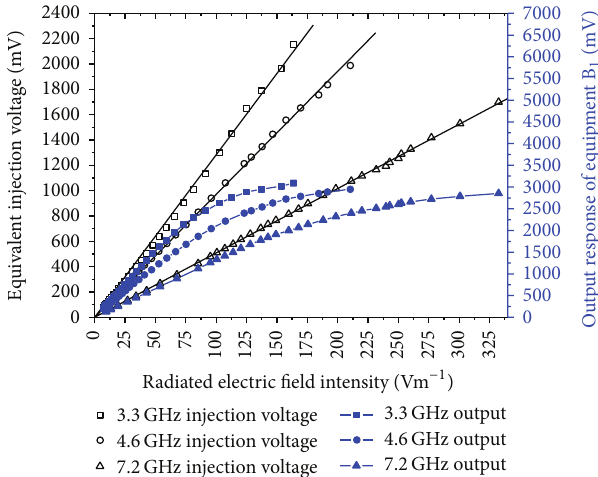
Figure 14: The relation curves between the equivalent injection voltage and the radiated electric field intensity.